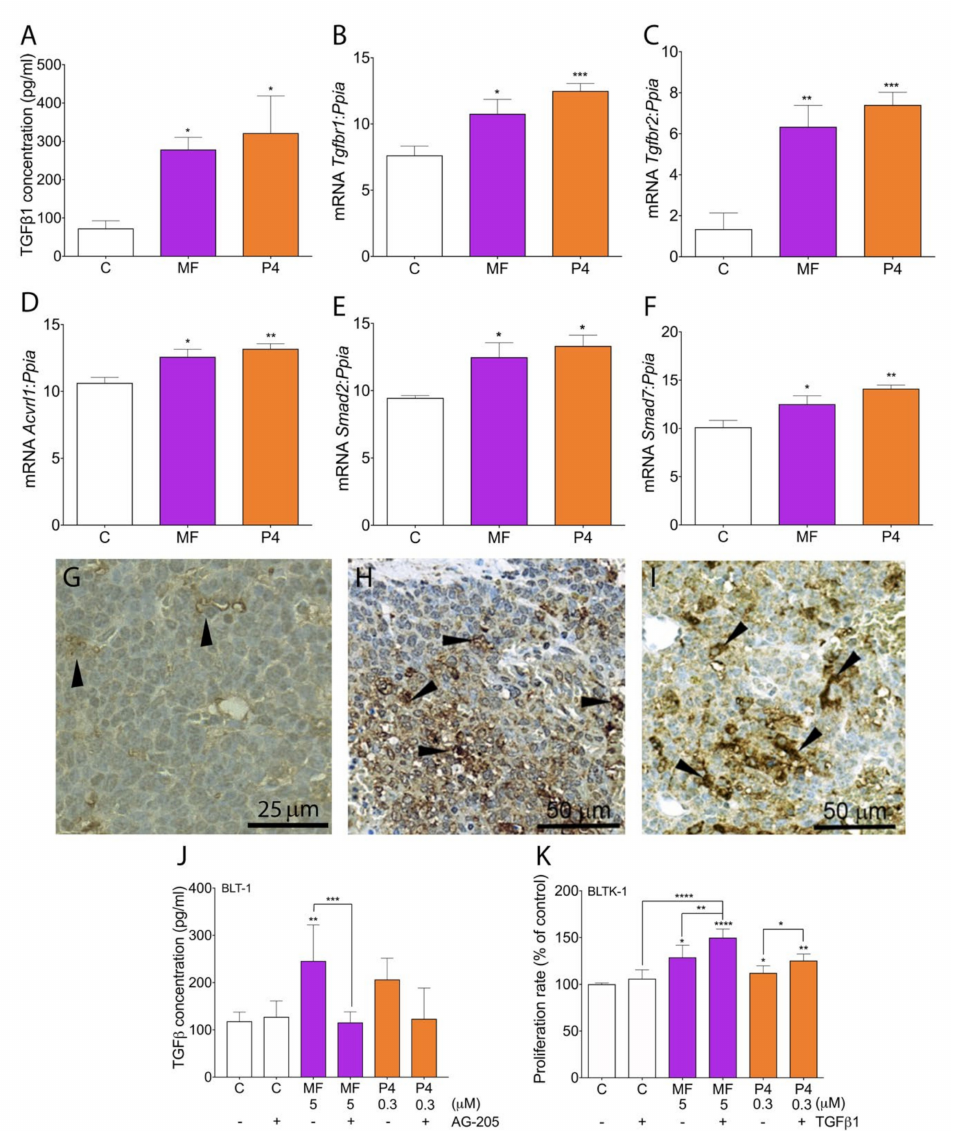
Figure 6. MF and P4 treatments e ff ects on TGF β 1 superfamily signaling pathways. TGF β 1 serum level in the control, MF-treated or P4-treated tumors of Inh α / Tag TG mice ( A ). qPCR analysis of the Tgfbr1 ( B ) , Tgfbr2 ( C ) , Acvrl1 (Alk1) ( D ), Smad2 ( E ), and Smad7 ( F ) expression levels in the control, MF-treated and P4-treated tumors of Inh α / Tag TG mice. Each bar represents the mean ± SEM relative to Ppia. Immunohistochemical staining of TGF β R2 in the C ( G ), MF-treated ( H ) and P4-treated ( I ) tumors of Inh α / Tag TG mice. Black arrows indicate Tgf β r2 positive staining. Scale bar, 25 µ m or 50 µ m. TGF β 1 level in the control, MF-treated or P4-treated BLTK-1 cells with or without the AG-205 inhibitor ( J ). E ff ects of recombinant TGF β 1 treatment on MF- or P4-treated BLTK-1 cells ( K ). The proliferation level of the treated groups is presented as the percentage of control proliferation, considered as 100%. Asterisks indicate significant di ff erences between the non-treated control and treated groups (*, p < 0.05; **, p < 0.01; ***, p < 0.001; ****, p < 0.0001). AG-205, PGMC1 inhibitor; C, control; Inh α / Tag TG mice; transgenic mice expressing the SV40 Taq oncogene under the inhibin α promoter; MF, mifepristone; ND, non-detectable; P4,